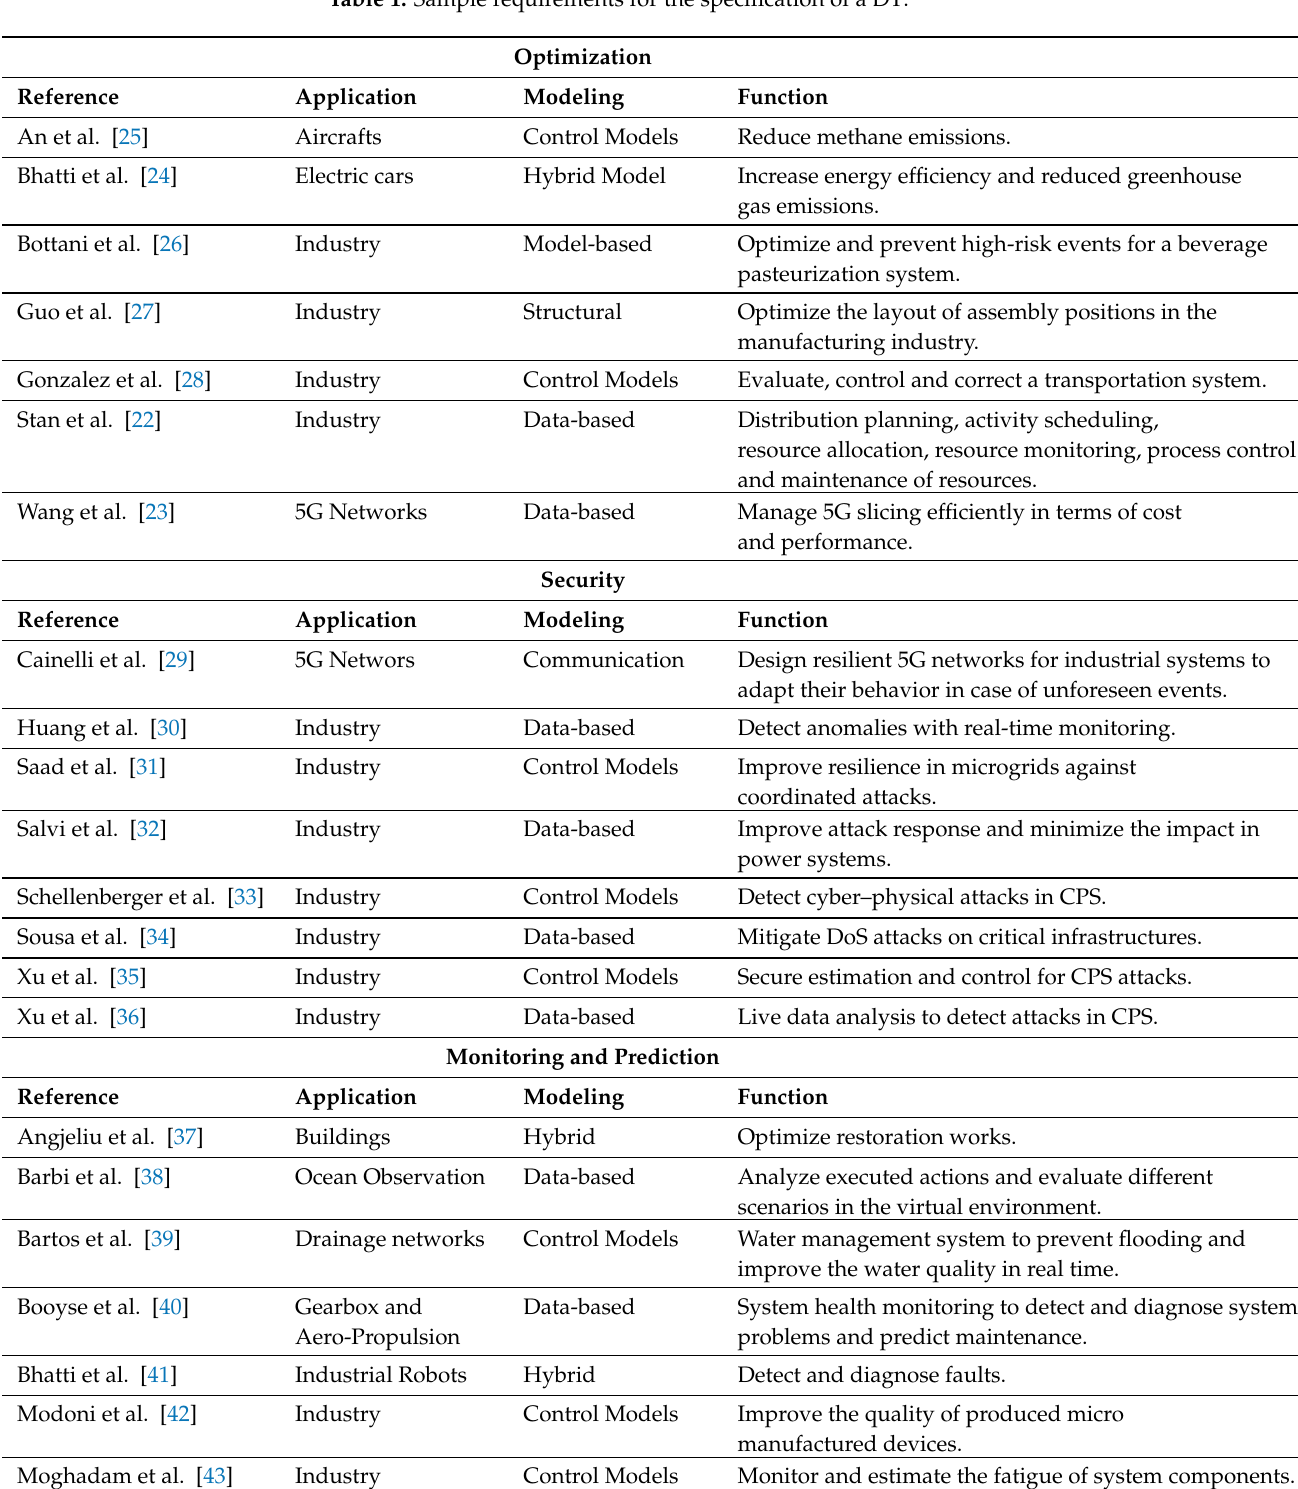
Table 1. Sample requirements for the specification of a